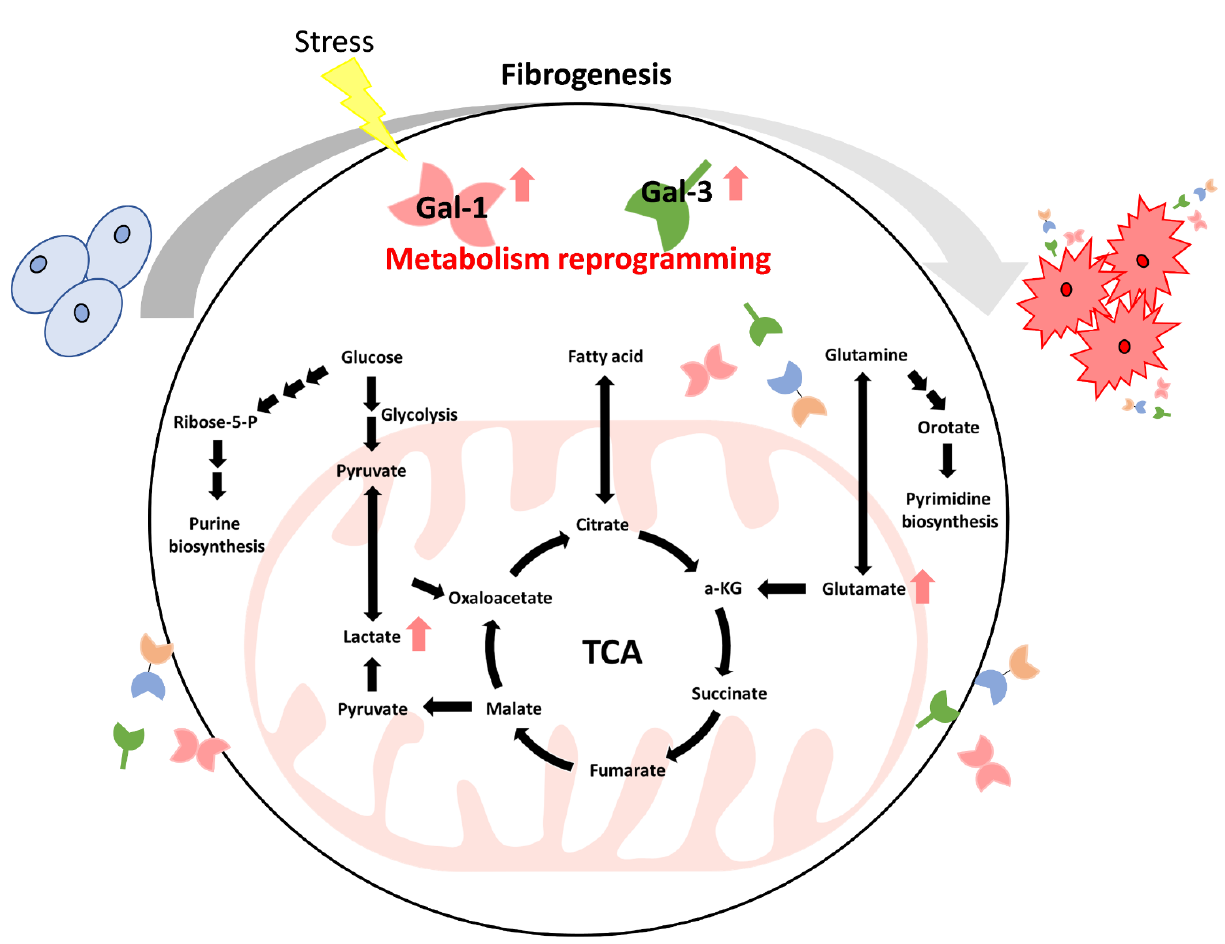
Figure 4. Metabolic reprogramming-associated fibrogenesis induction of galectin expression. The schematic diagram illustrates that metabolic reprogramming accompanies organ fibrogenesis and dysregulated Gal expression during stress stimulation.